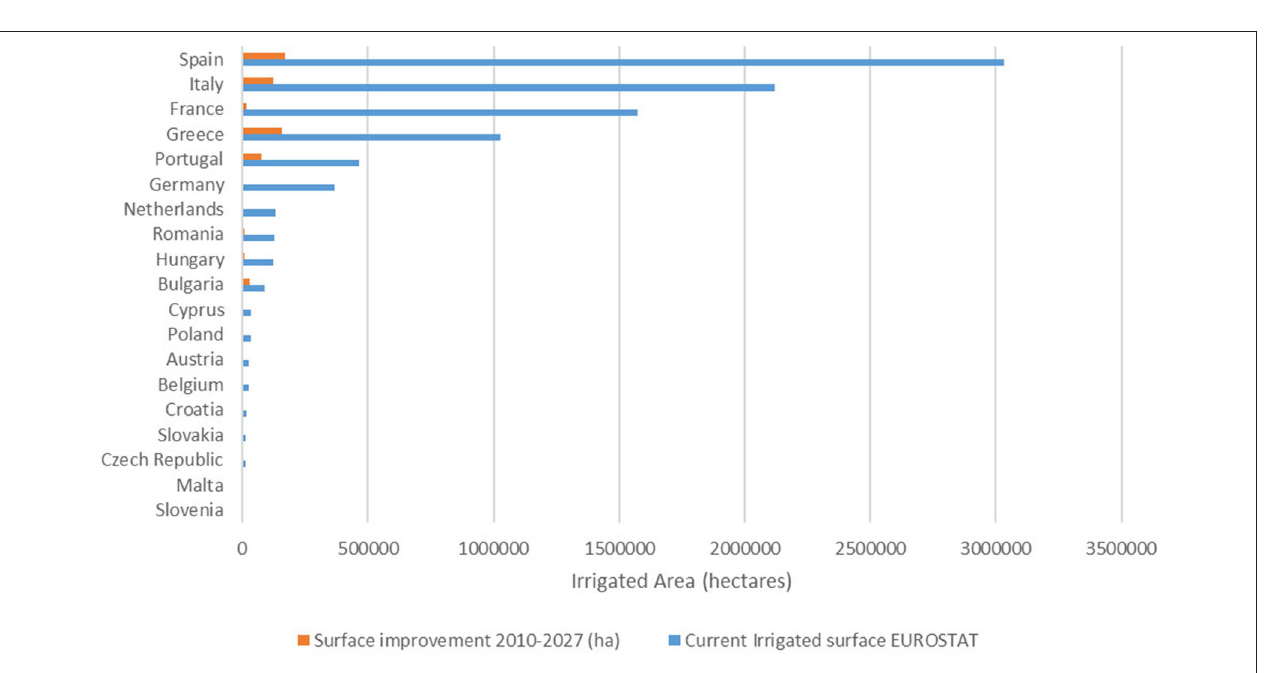
irrigation. Spain, Greece, Italy, and Portugal plan more changes, but still restricted to 5–10% of the total irrigated